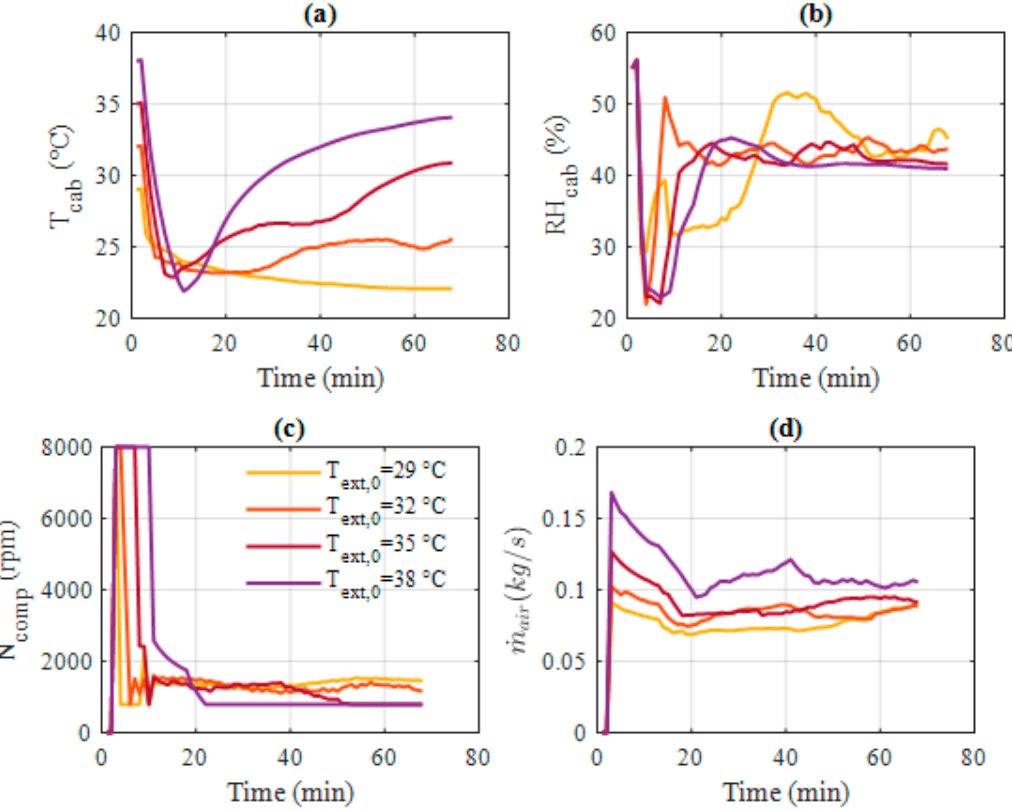
Figure 15. Cabin and command trajectories for a driver dressed in a formal way and for different outside temperature profiles: ( a ) Temperature, ( b ) Relative humidity, ( c ) Compressor rotational speed, ( d ) Air flow.